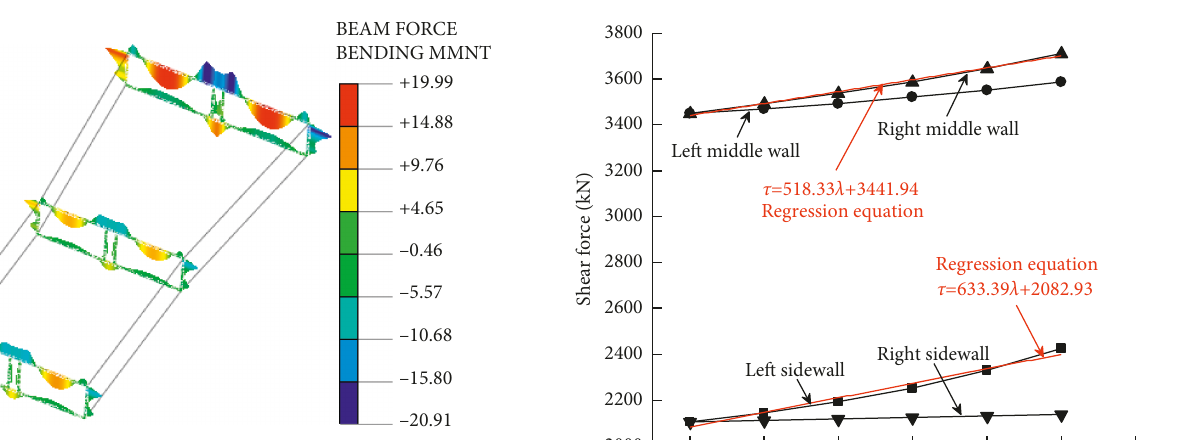
Figure 22: The bending moment of segment E1 under torsion condition 12 ( × 100kN · m).